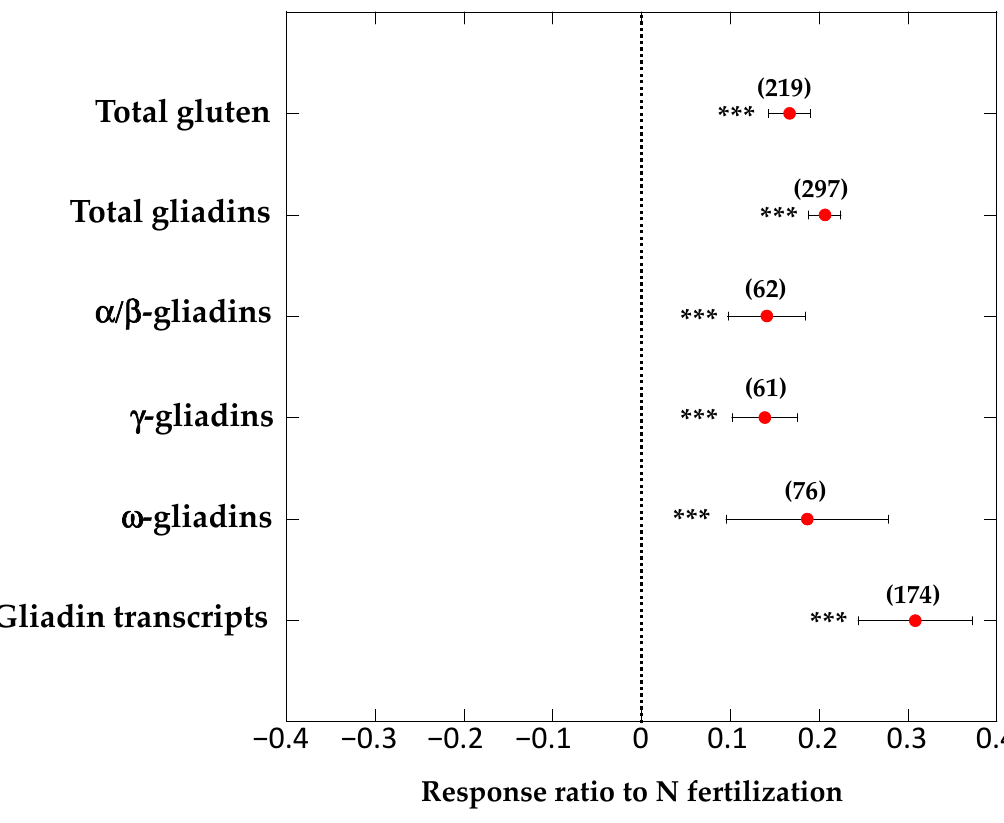
Figure 2. Response ratios ( ± 95% CI) of contents of total gluten, total gliadins, α / β -gliadins, γ -gliadins and ω -gliadins and gliadin transcripts in wheat grains after an increase in N fertilisation. See Table 1 and References therein for the sources. The number into parenthesis indicates the number of studies. *** p < 0.0001.